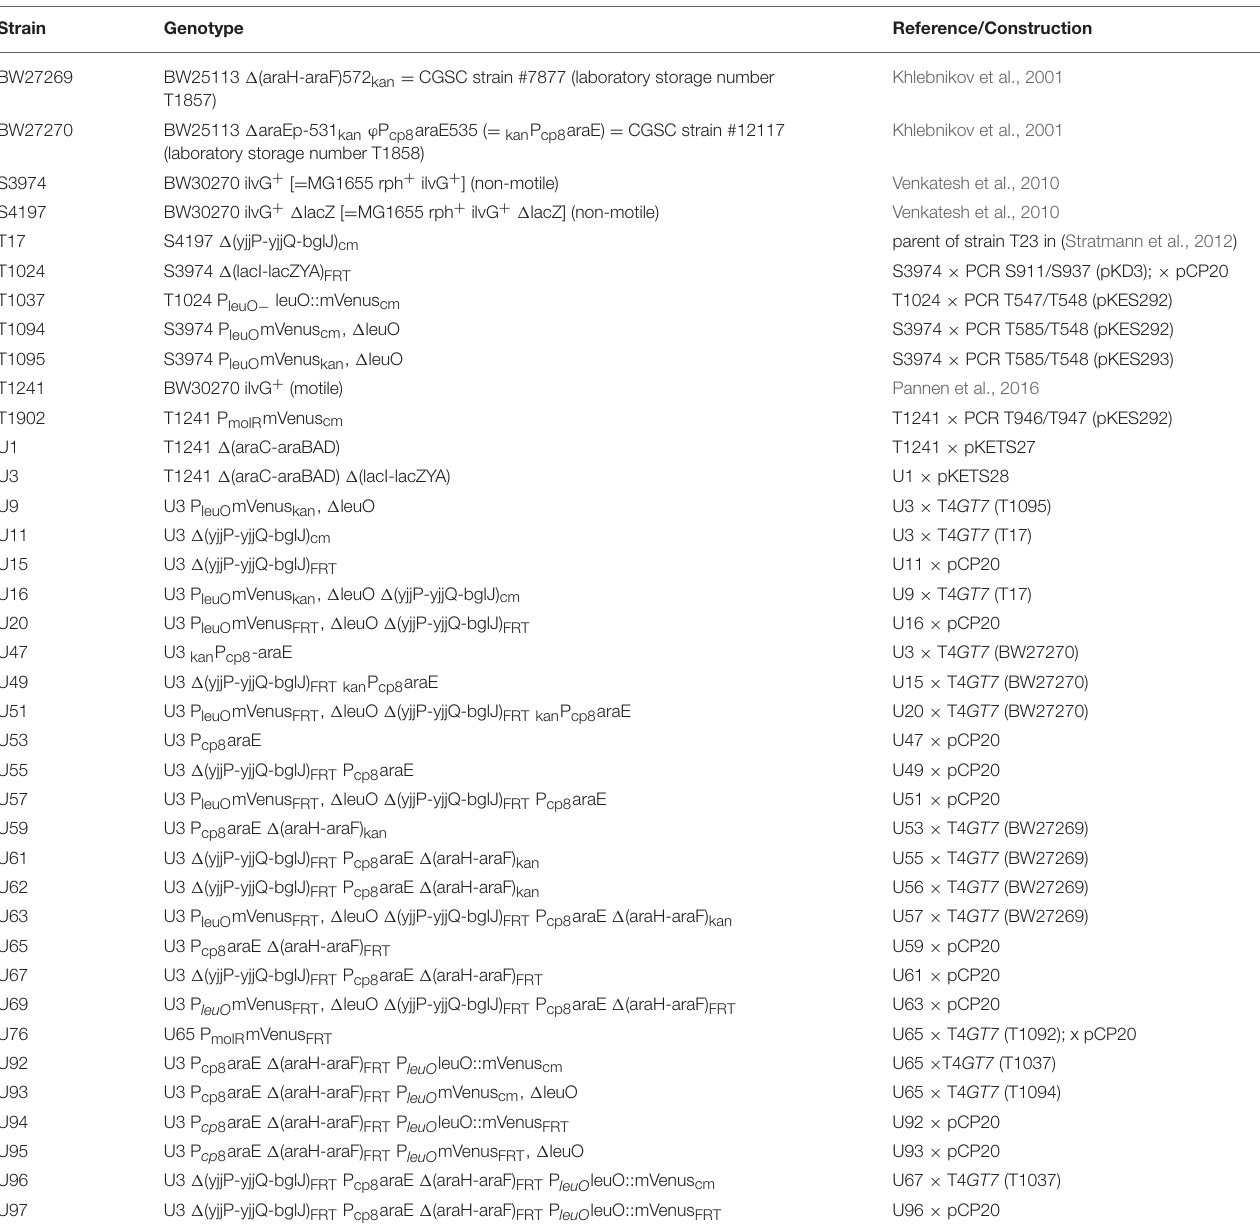
TABLE 1 | E. coli K12